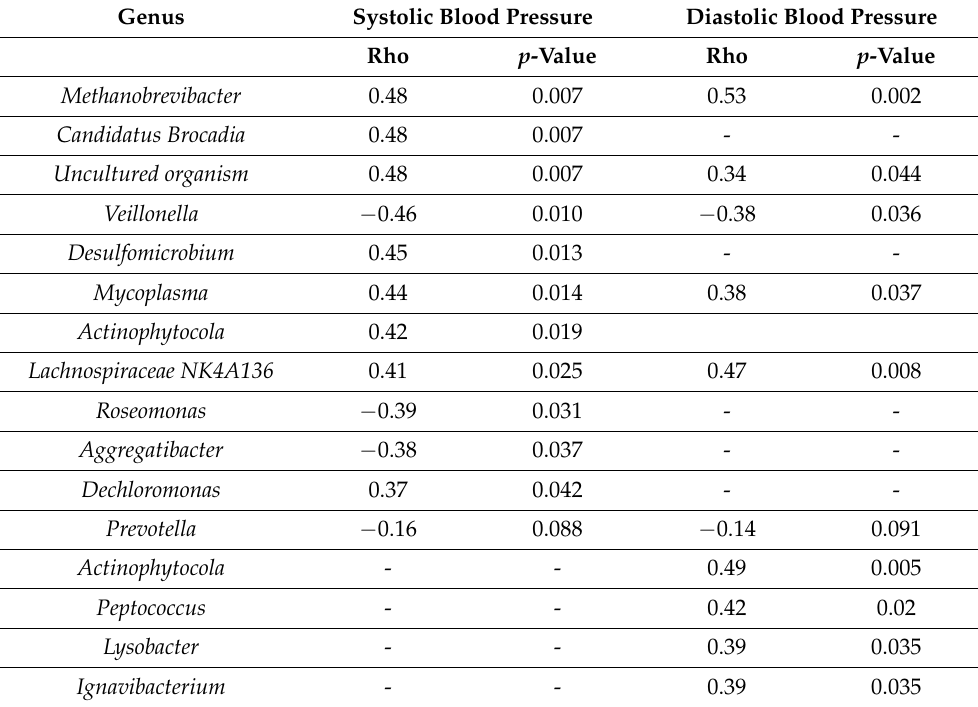
Table 2. Significant correlations between oral bacteria and systolic or diastolic blood pressure. Genus Systolic Blood Pressure Diastolic Blood Pressure Rho p -Value Rho Methanobrevibacter Candidatus